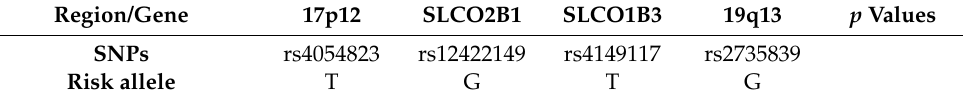
Table 4. Cumulative association of SNPs with prostate